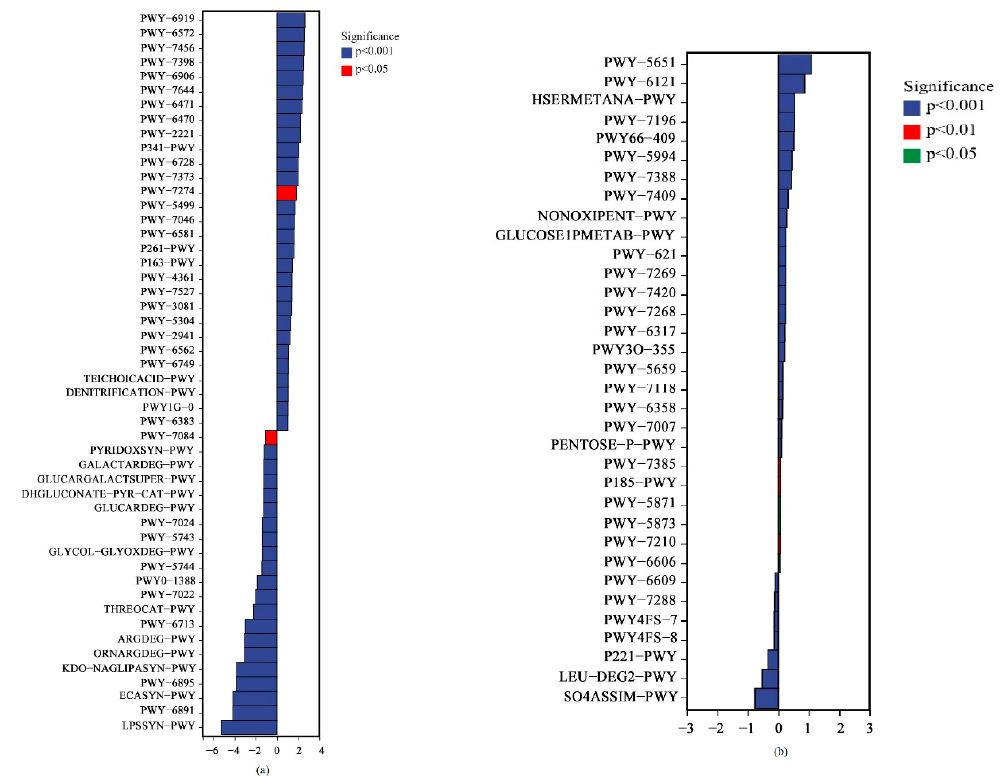
Figure 11. Differential analysis of metabolic pathways in microbial communities between Ma, PsMa, and Ps. ( a ): litter bacterial communities; ( b ): litter fungal bacterial. Ma: Morus alba ; PsMa: Pinus sylvestris var. mongolica × Morus alba ; Ps: Pinus sylvestris var. mongolica .